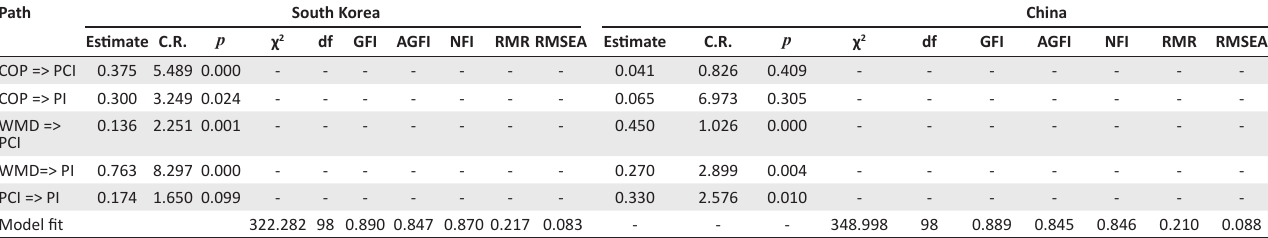
TABLE 6: Structural equation modelling results of country-of-origin-image (COI) effects. Path Estimate